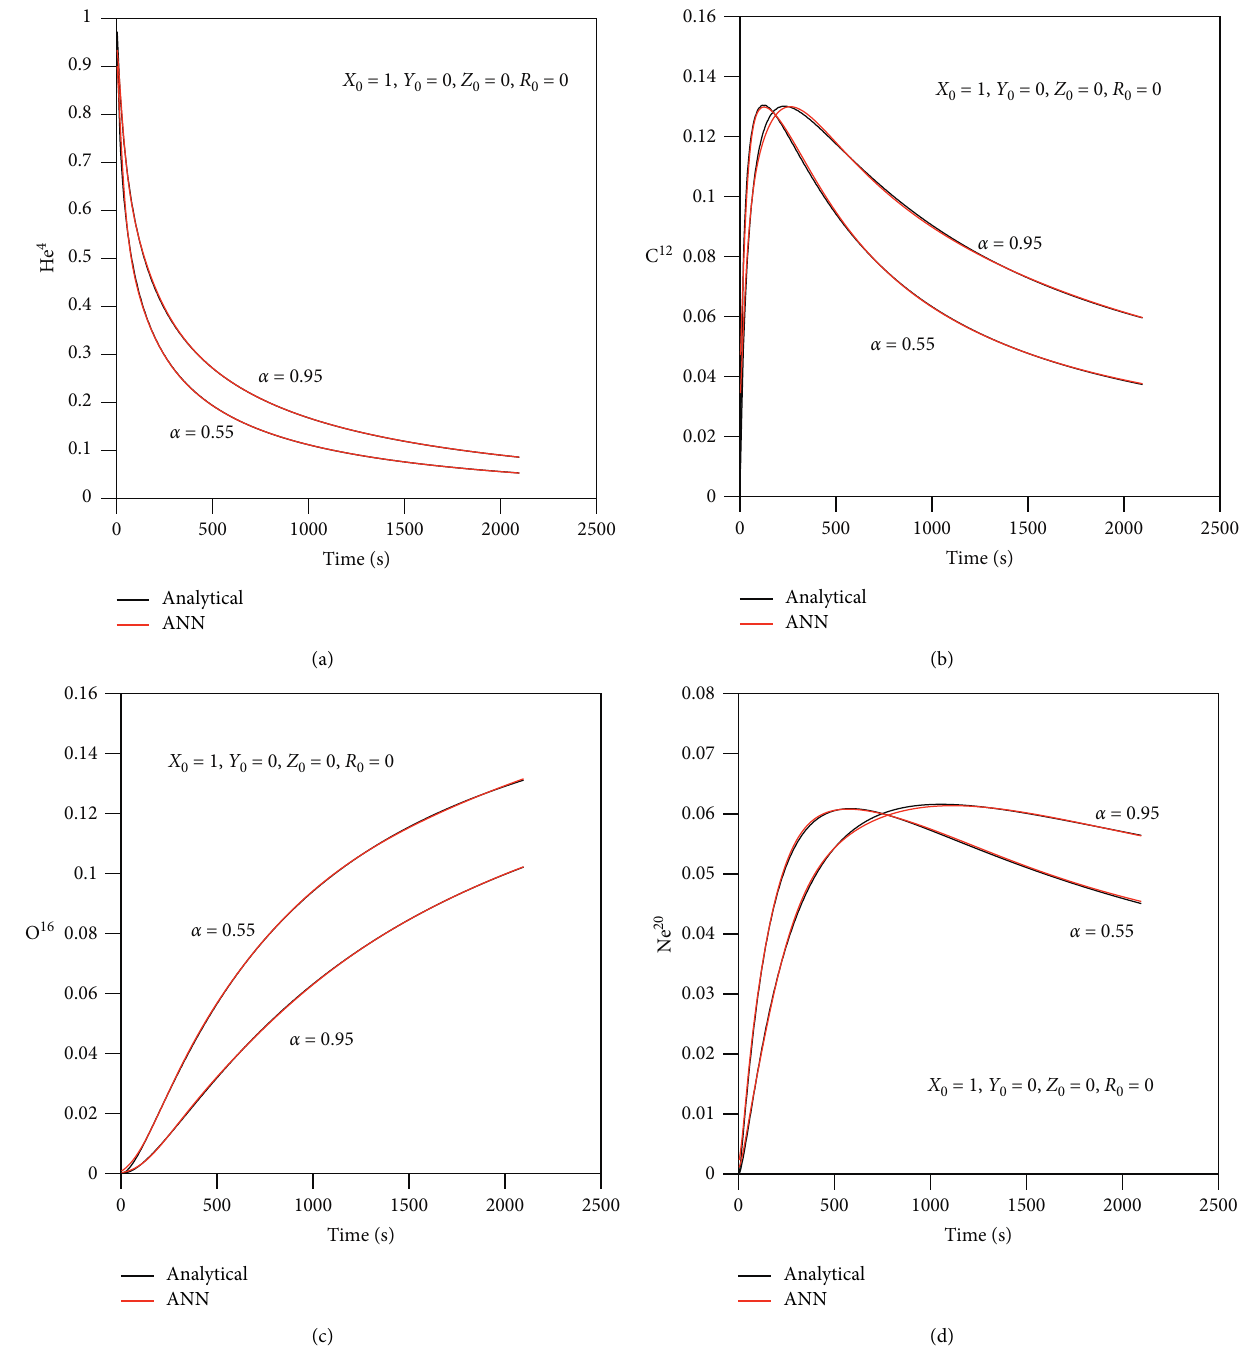
Figure 9: The distribution of the product abundance with time for the pure helium burning network, X